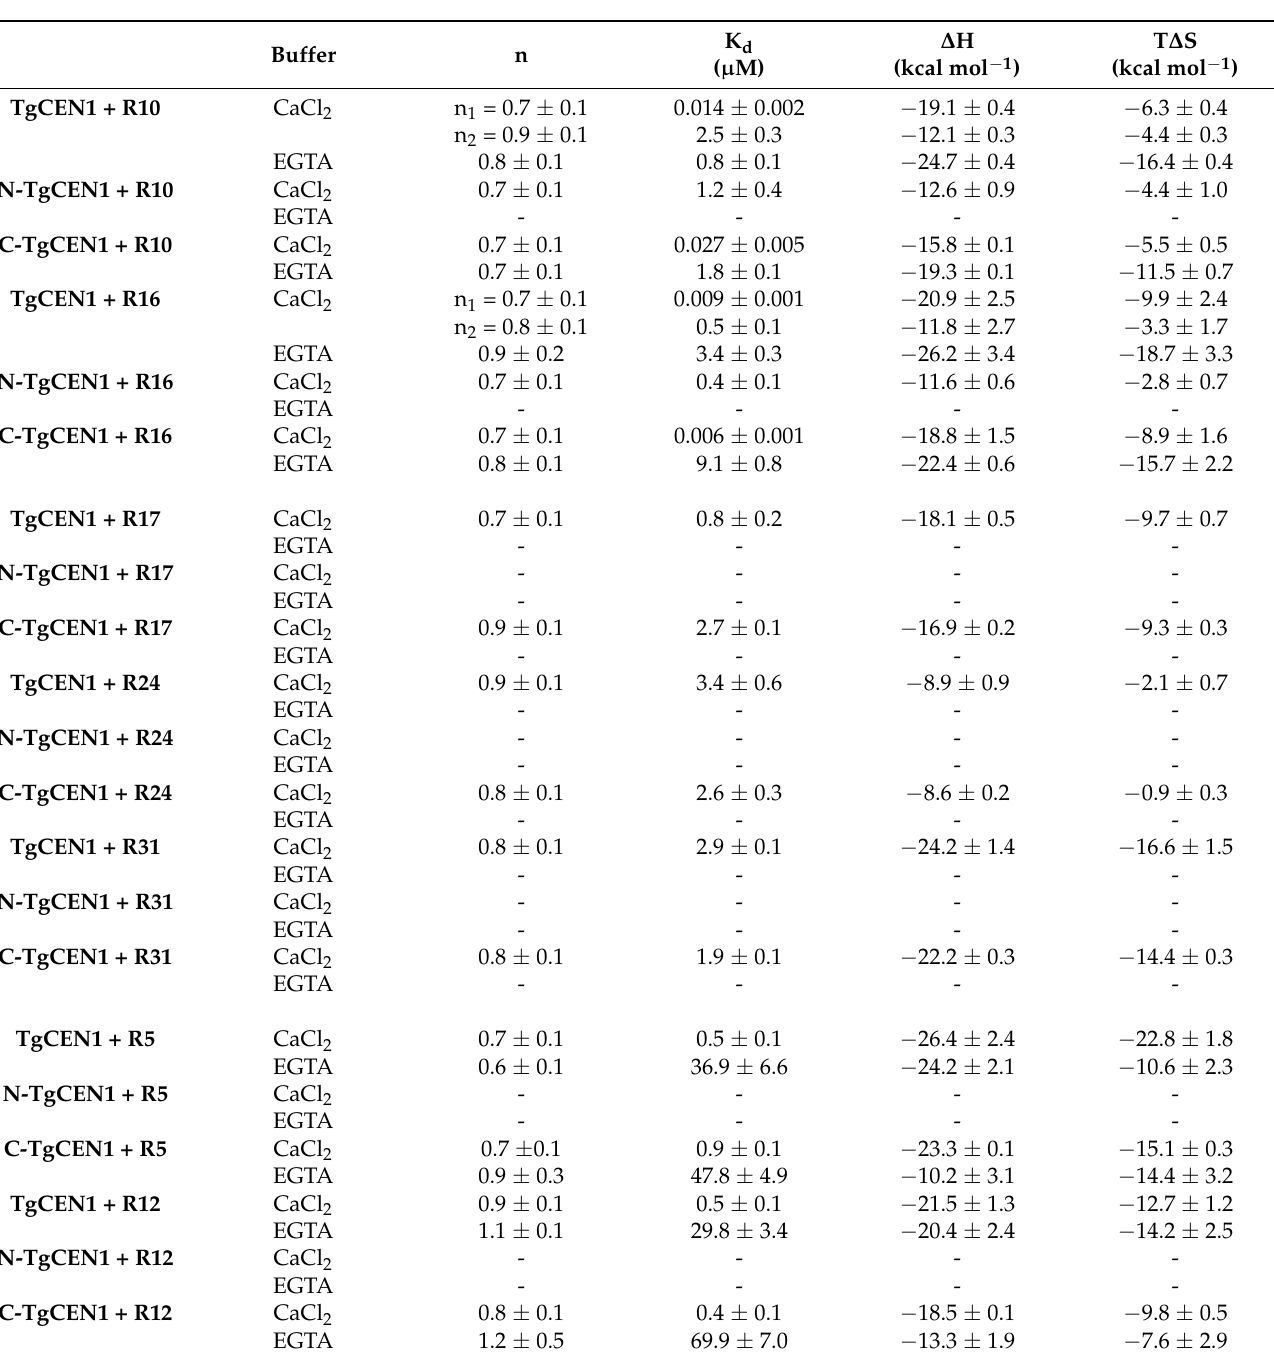
Table 1. Summary of the thermodynamic parameters of the interaction between TgCEN1 and its N-terminal and C-terminal domains with the peptides derived from TgSFI1. n—stoichiometry of binding; K d —dissociation constant; T—298